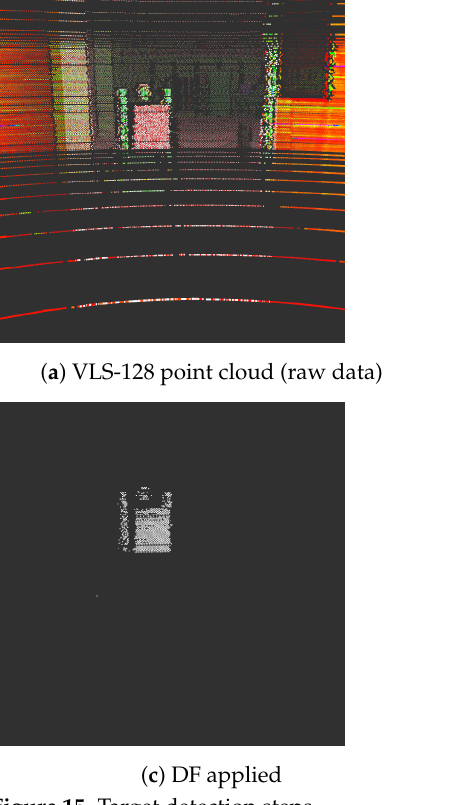
Figure 15. Target detection steps.